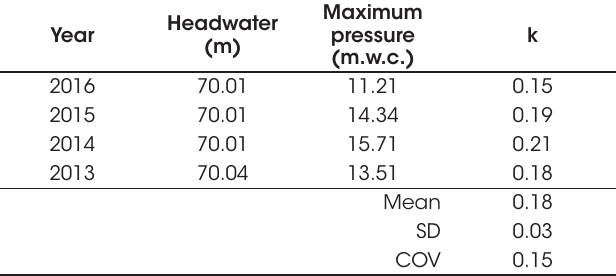
Maximum annual values of k